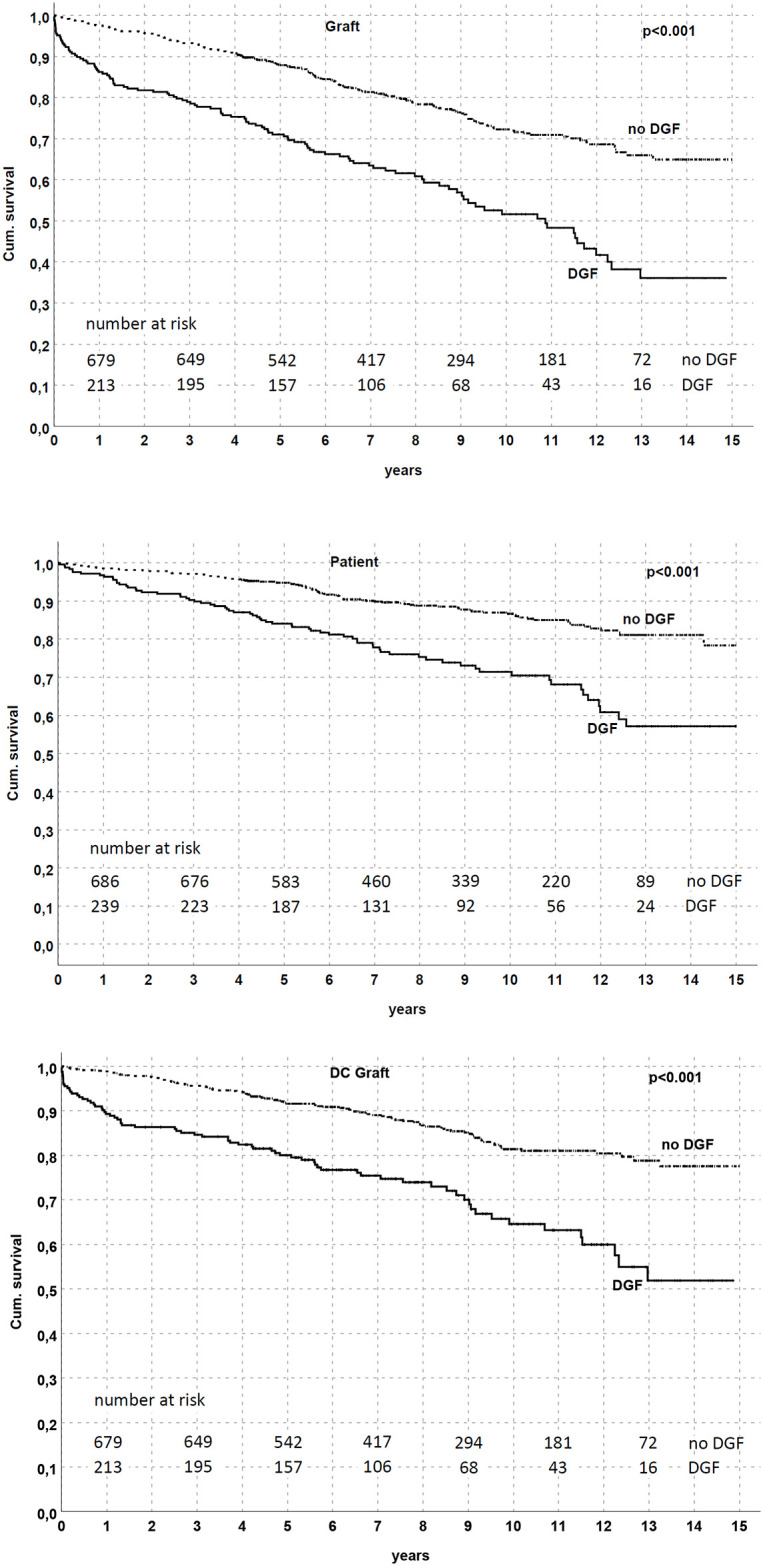
Graft and patient survival by DGF in the studied population.Graft, patient, and death-censored graft survival were all reduced in patients who experienced DGF (p<0.001 in all analyses).